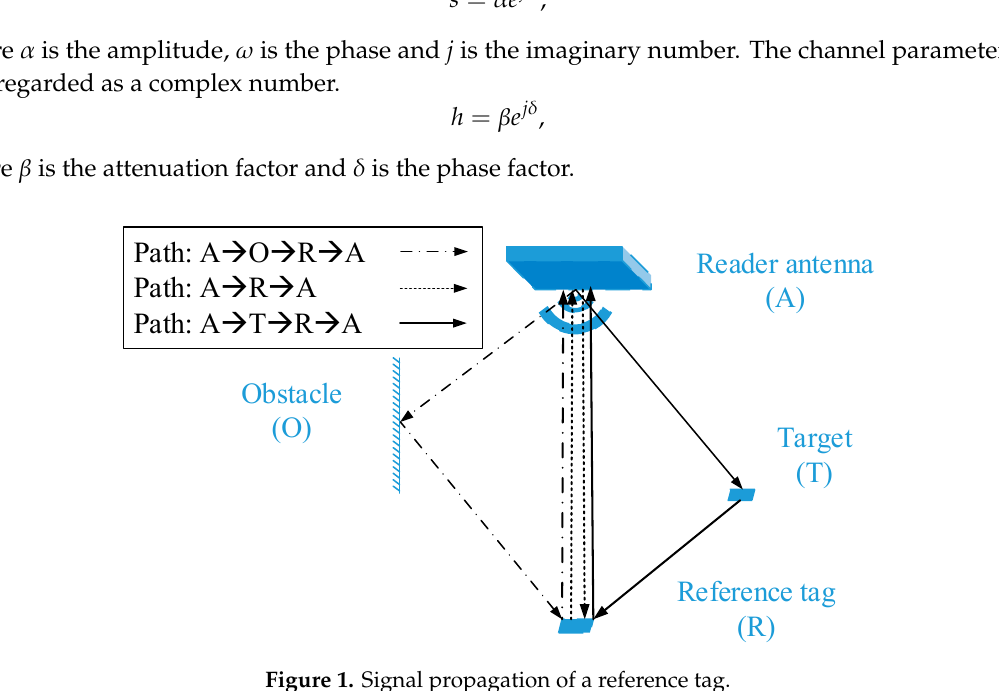
Figure 1. Signal propagation of a reference tag.